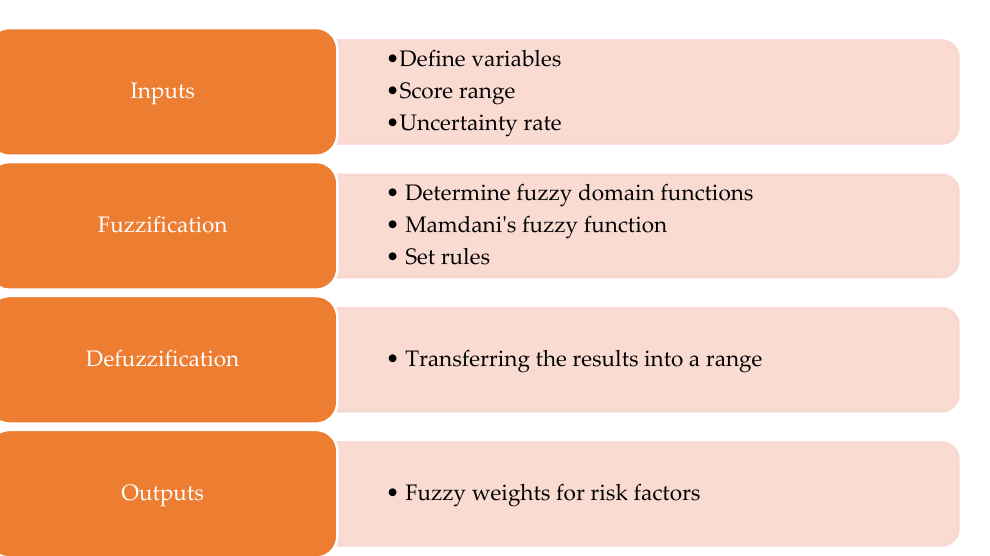
Figure 3. The MISO-based FIS model.